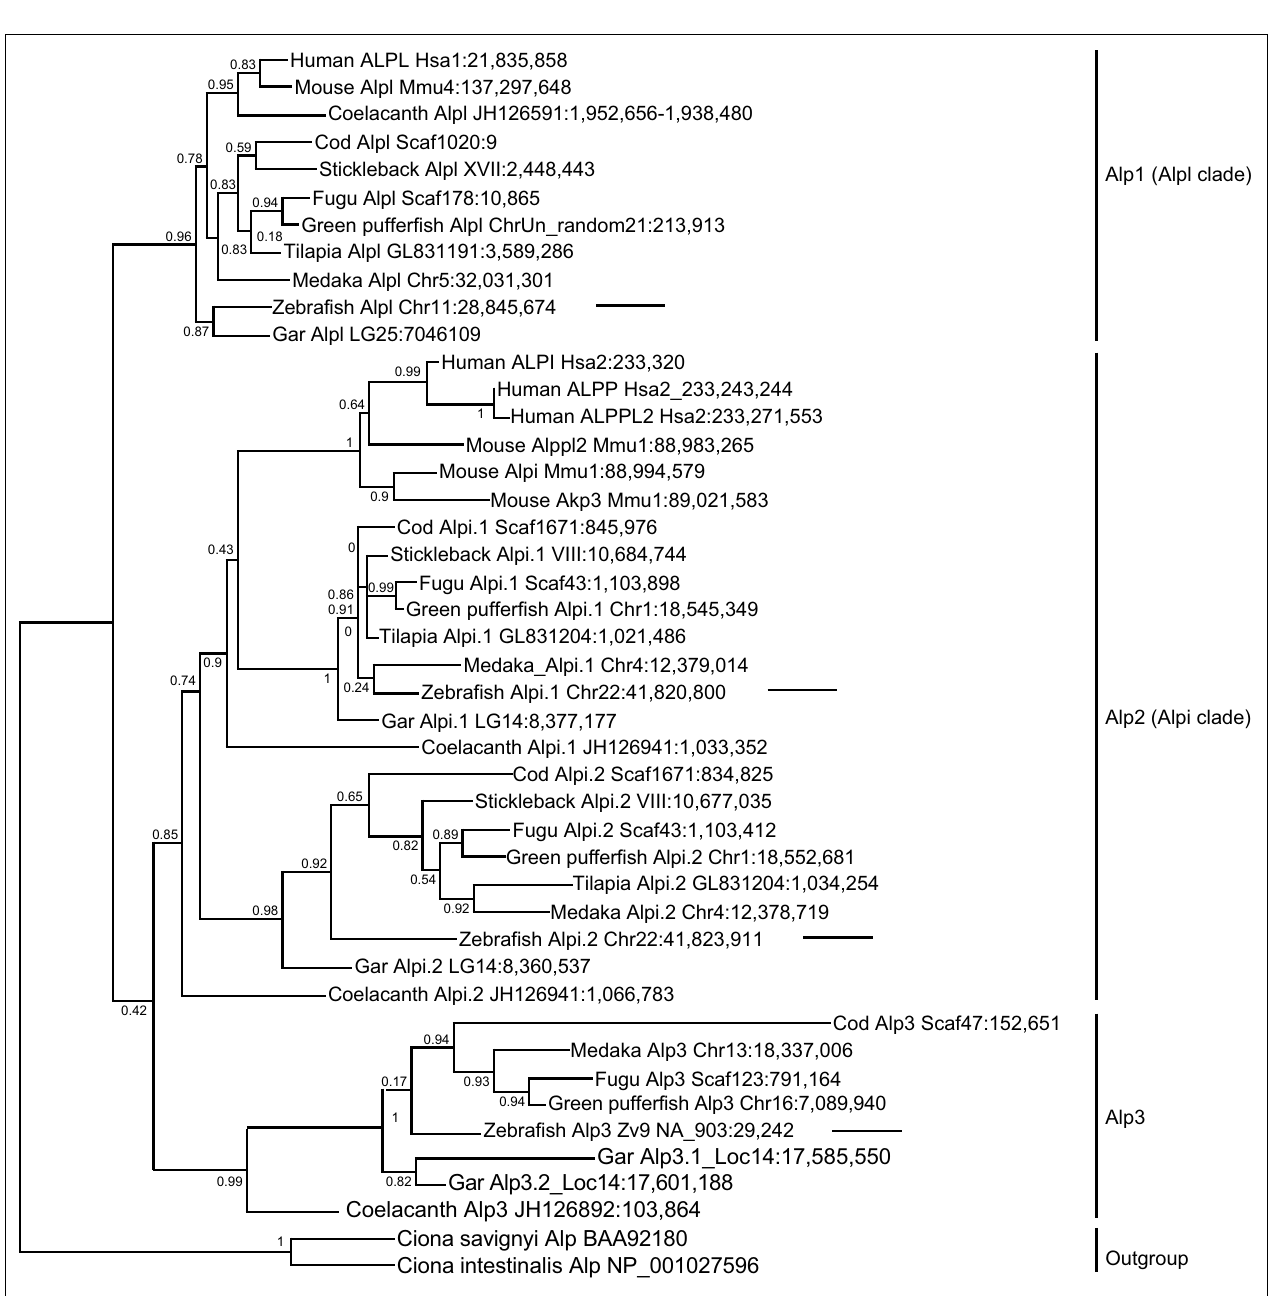
encoding this protein on human chromosome 1 at nucleotide position 21,835,858 according to Ensembl Release 68 (July 2012) and Pre-Ensembl Release 66 (April 2012).The tree has three major clades [Alp1 (Alpl clade), Alp2 (Alpi clade), and Alp3]. Arrows point to the four zebrafish Alp